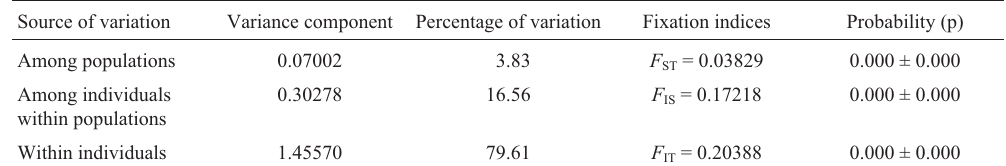
Table 2 - Hierarchical analysis of molecular variance (AMOVA) within and among catfish